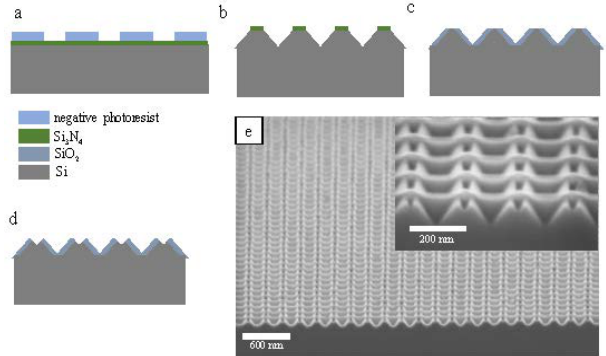
Figure 9: Fabrication overview of the INPG structure. (a) Nanopat- terning by LIL. (b) After dry etching of the SiN mask and KOH wet anisotropic etching. (c) After thermal oxidation and removing the SiN mask by hot H 3 PO 4 . (d) INPGs were fabricated by the second KOH wet etching. (e) Picture of a fabicated INPG structure. Adapted from Ref. [44].